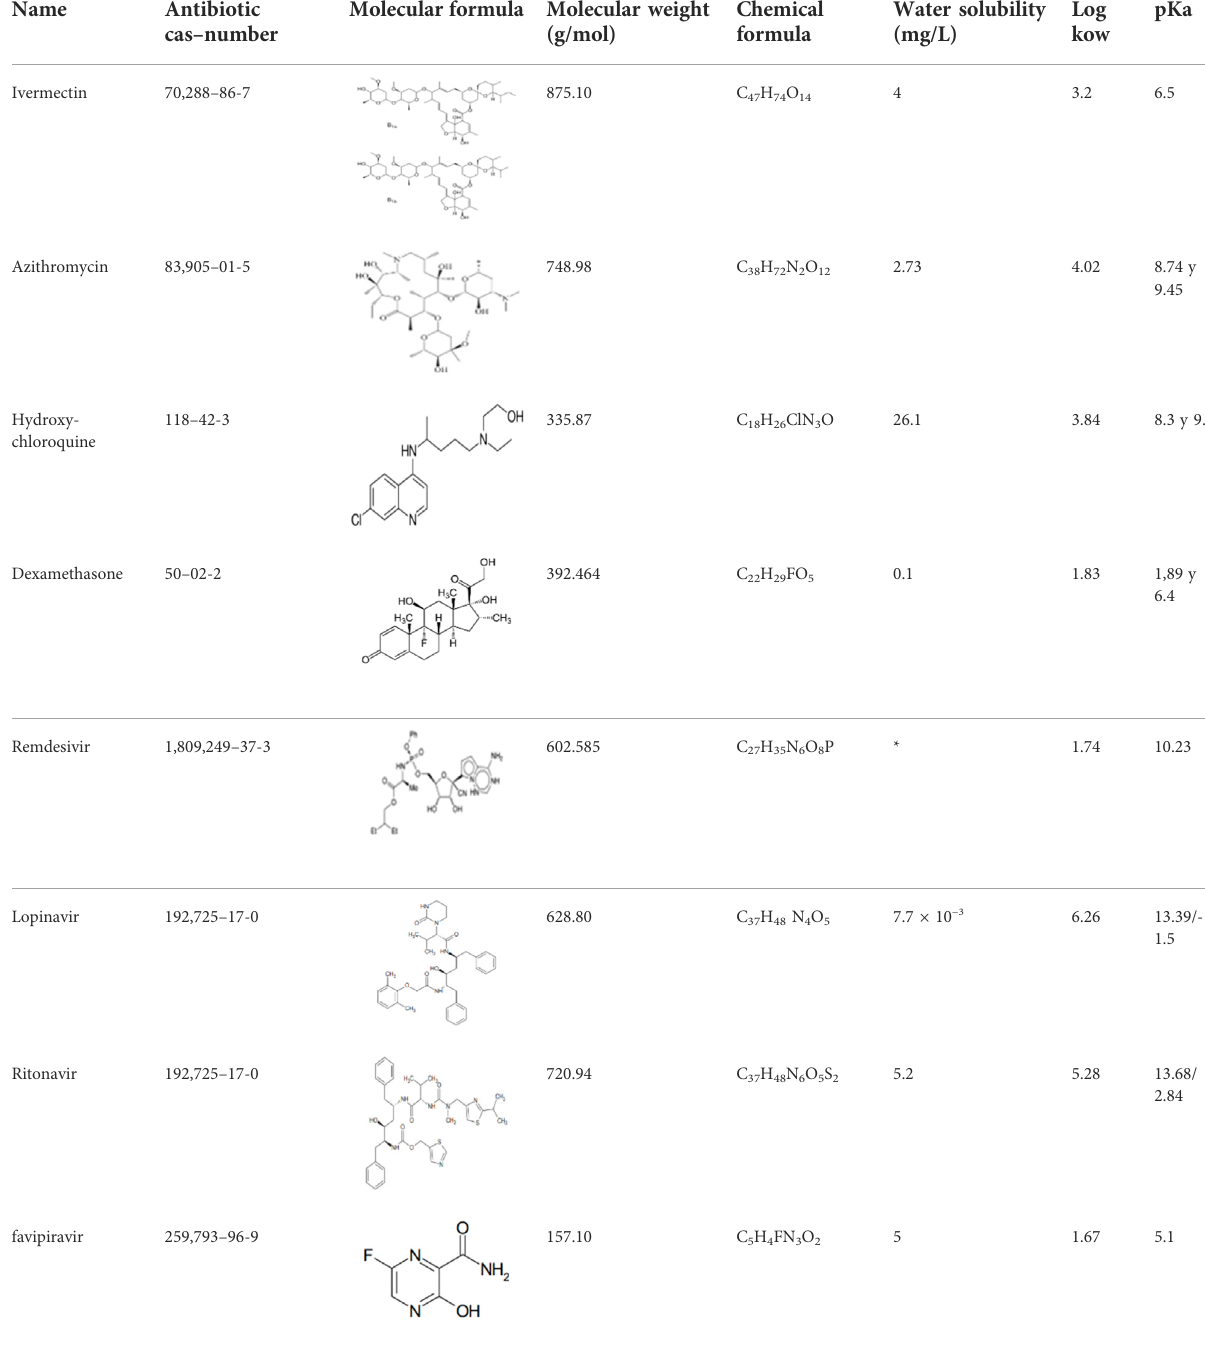
TABLE 1 Physicochemical properties of pharmaceutical residues used to treat COVID